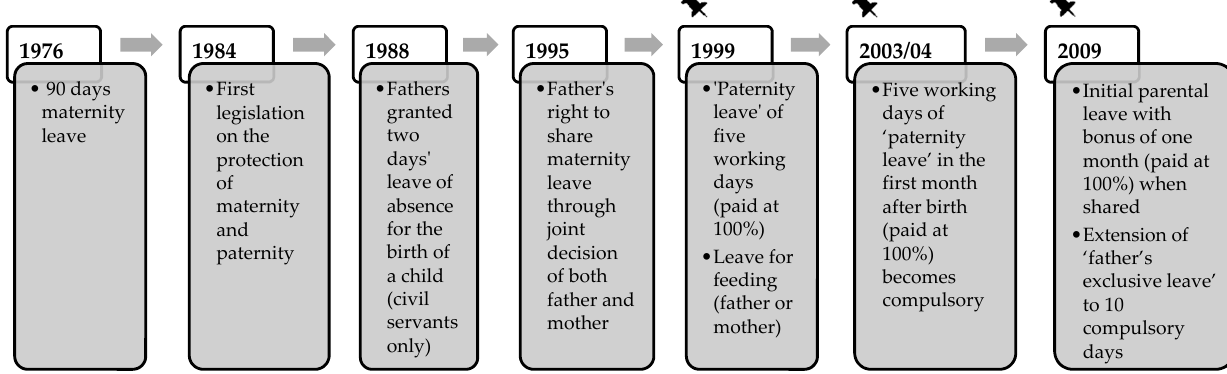
Figure 3. Developments in the legislation governing parenthood protection, 1976–2009.